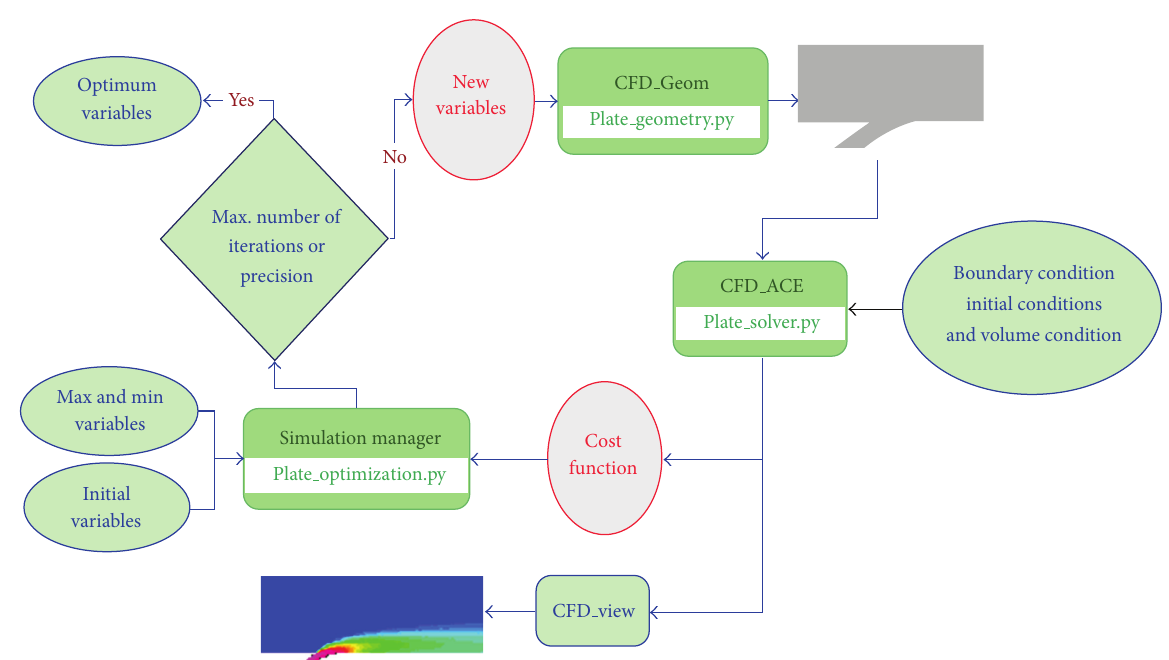
Figure 7: Optimization loop of CFD-ACE